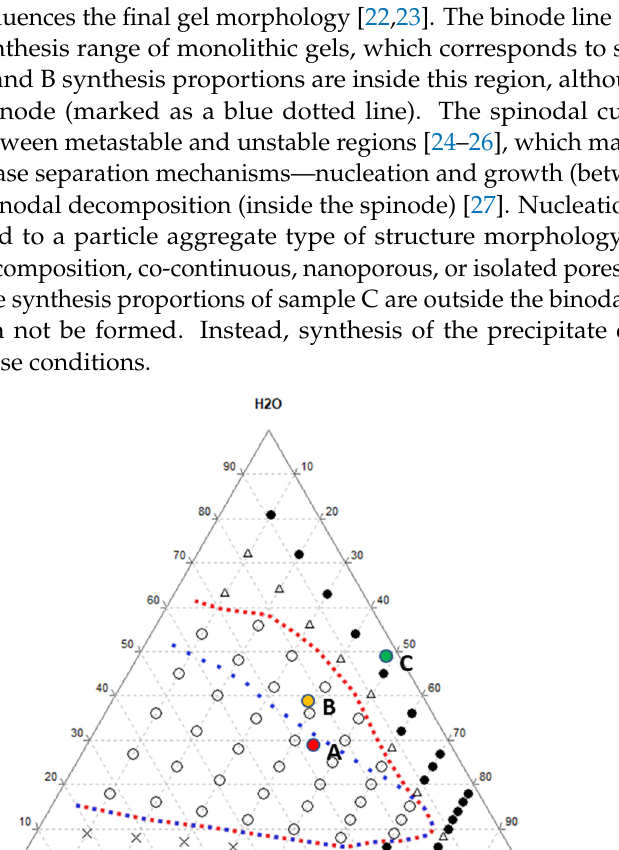
Figure 1. Schematic presentation of investigation concept.